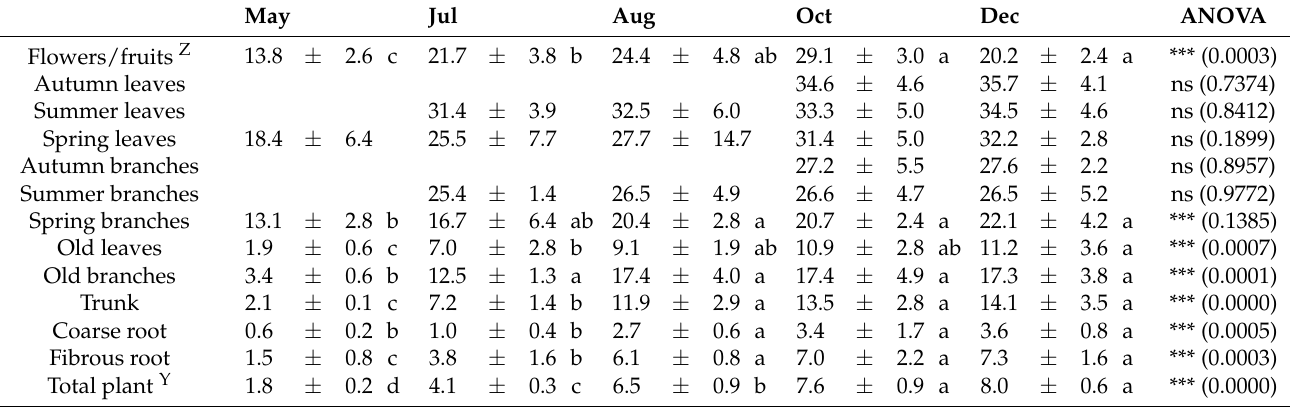
Table 6. Fe derived from fertilizer (Fedff, mg Fe) in the main organs of Nules clementine trees uprooted in May (flowering), July (fruit set and the end of fruit drop), August (fruit growth), October (fruit growth), and December (fruit maturity). Values are means ± SD (n = 4). Different lowercase letters indicate significant differences based on one-way analysis of variance. Significant effects of the Fe dose applied are given at p ≤ 0.001 (***) and ns (not significance) at each plant component. p -value between brackets (LSD